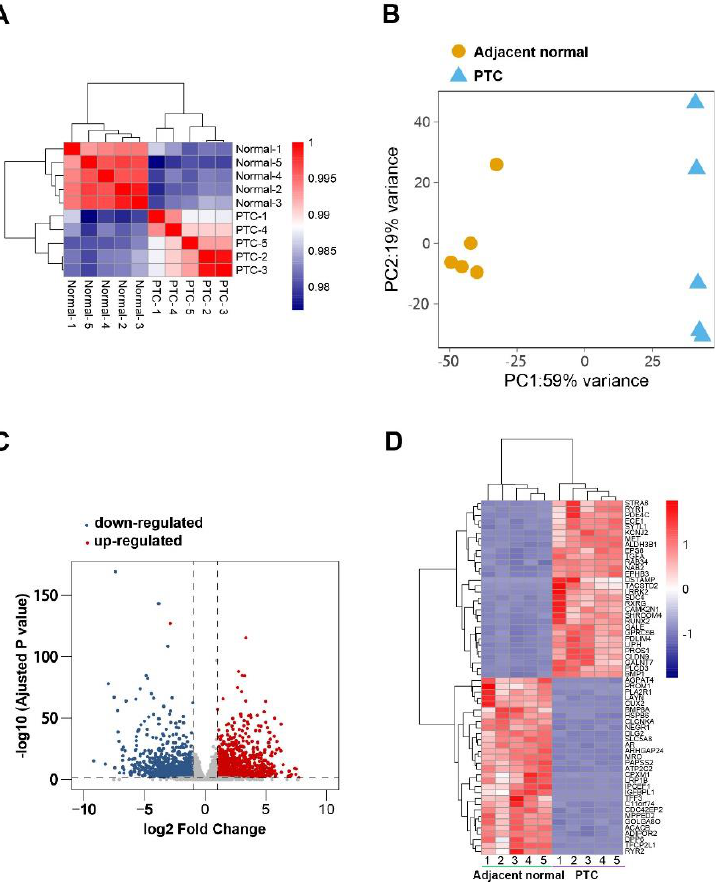
Figure 1. DEGs identification. ( A ) Pearson’s correlation of samples. ( B ) PCA of samples. ( C ) Volcano plot of gene expression. ( D ) Heatmap of top 30 upregulated and top 30 downregulated DEGs.